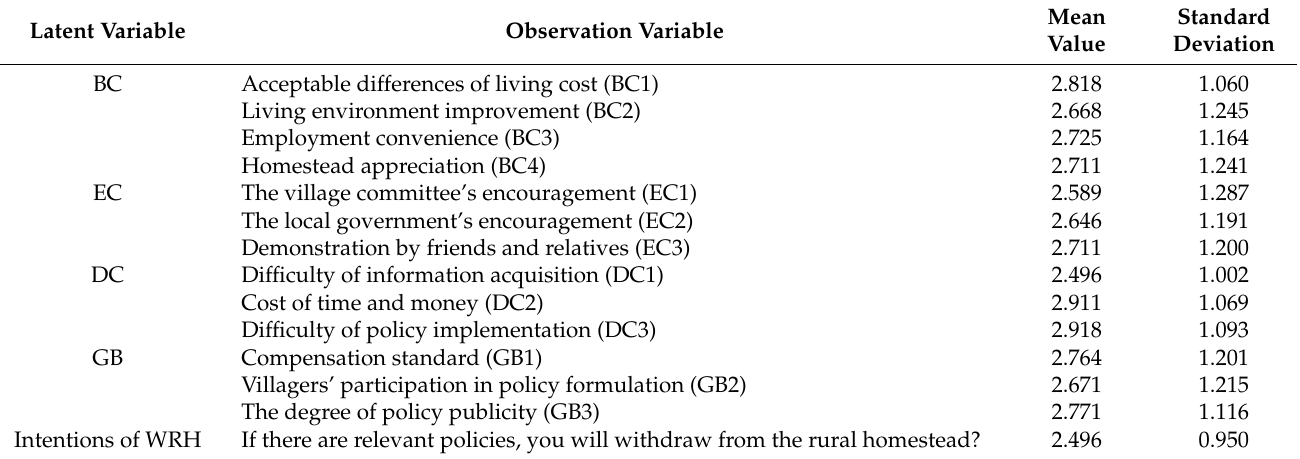
Table 2. Variable meaning and reliability and validity